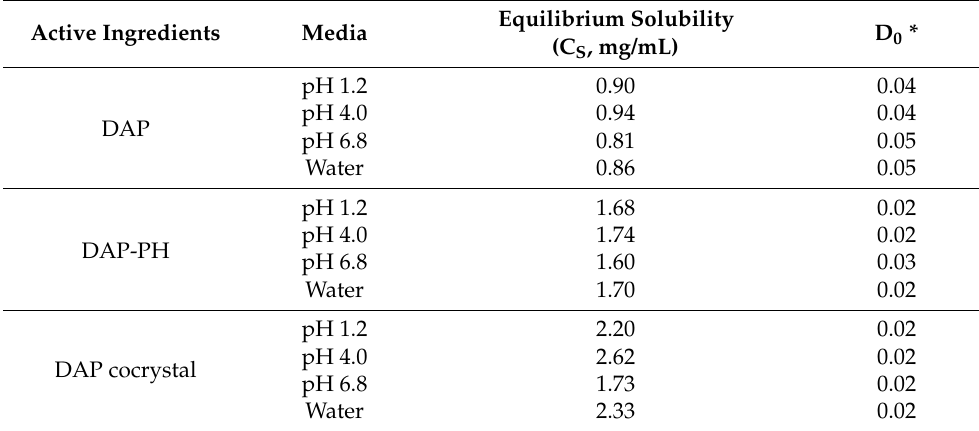
Table 3. Equilibrium solubility and dose number of dapagliflozin (DAP), dapagliflozin propanediol monohydrate (DAP-PH), and DAP cocrystal in various aqueous media. Equilibrium Active Ingredients Media